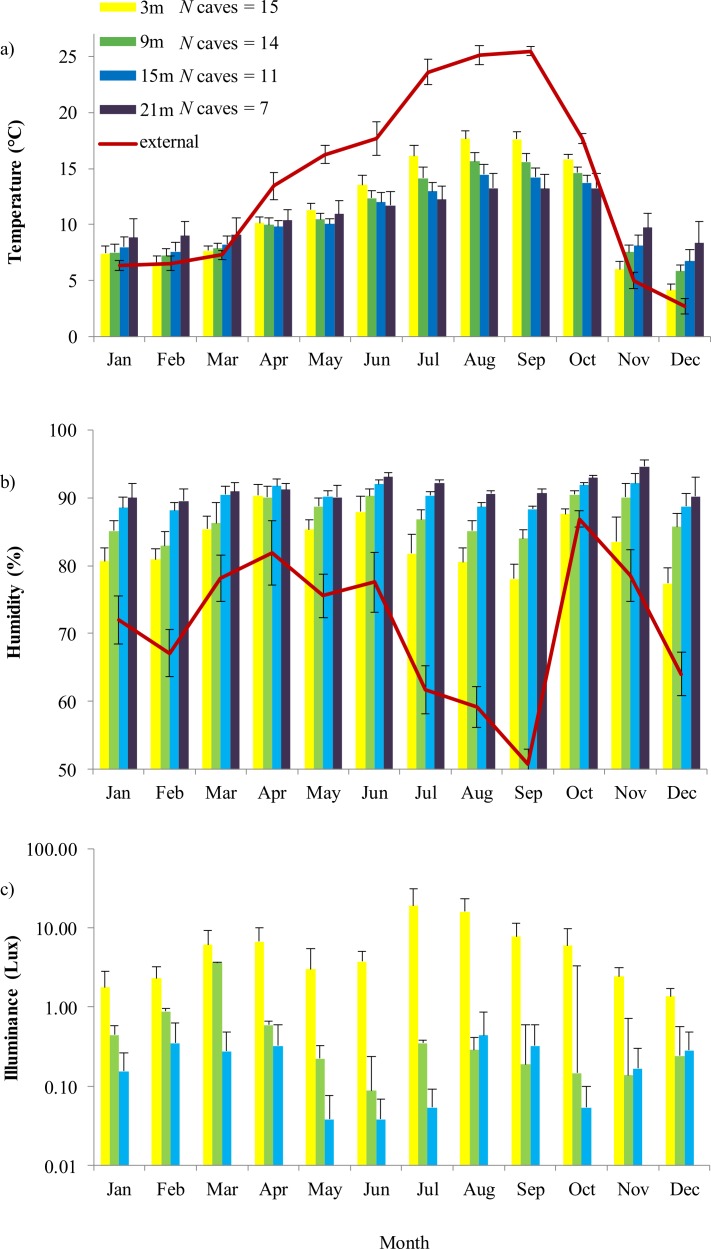
Annual variation of external environment and cave microhabitat.Internal variables are (A) temperature, (B) humidity and (C) illuminance (lux). In each graph, colored plots represent sectors located at different distance from the entrance (from 3 to 21 m). These sectors represent the area in which microclimate variability is higher; at 21 m illuminance was constantly 0 lux. Error bars are standard errors. For temperature and humidity, the trend of the respective external feature is also shown, represented by a continuous red line.